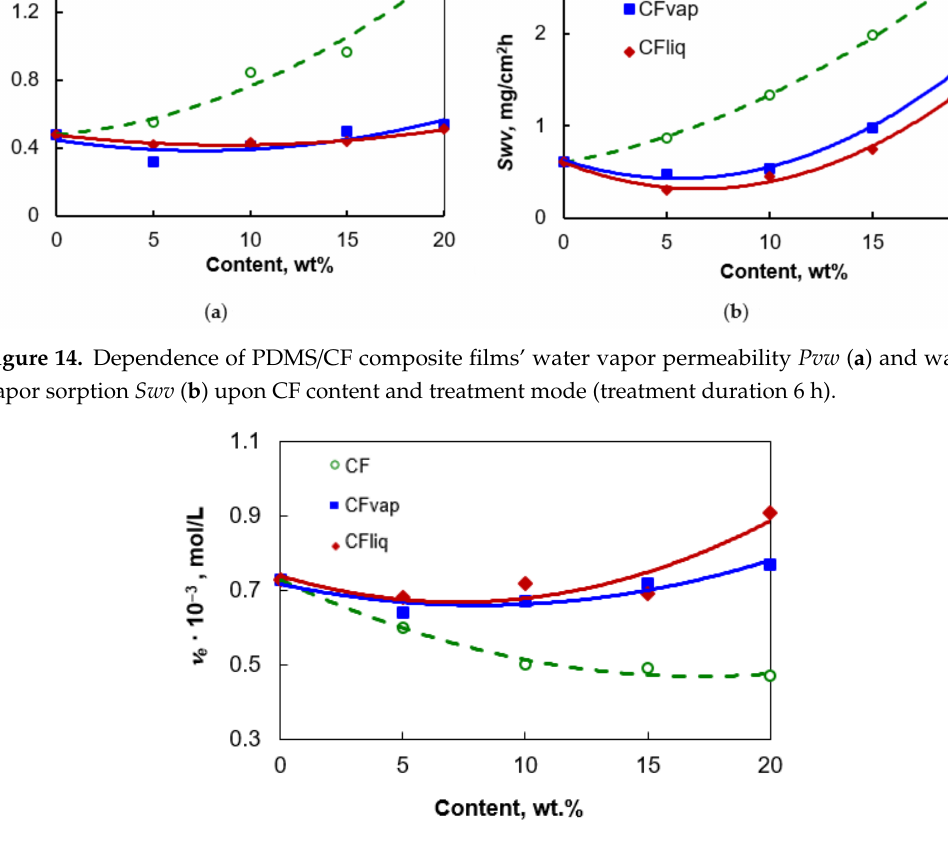
Figure 15. Dependence of PDMS crosslinking density ν e upon CF content and treatment mode (treatment duration 6